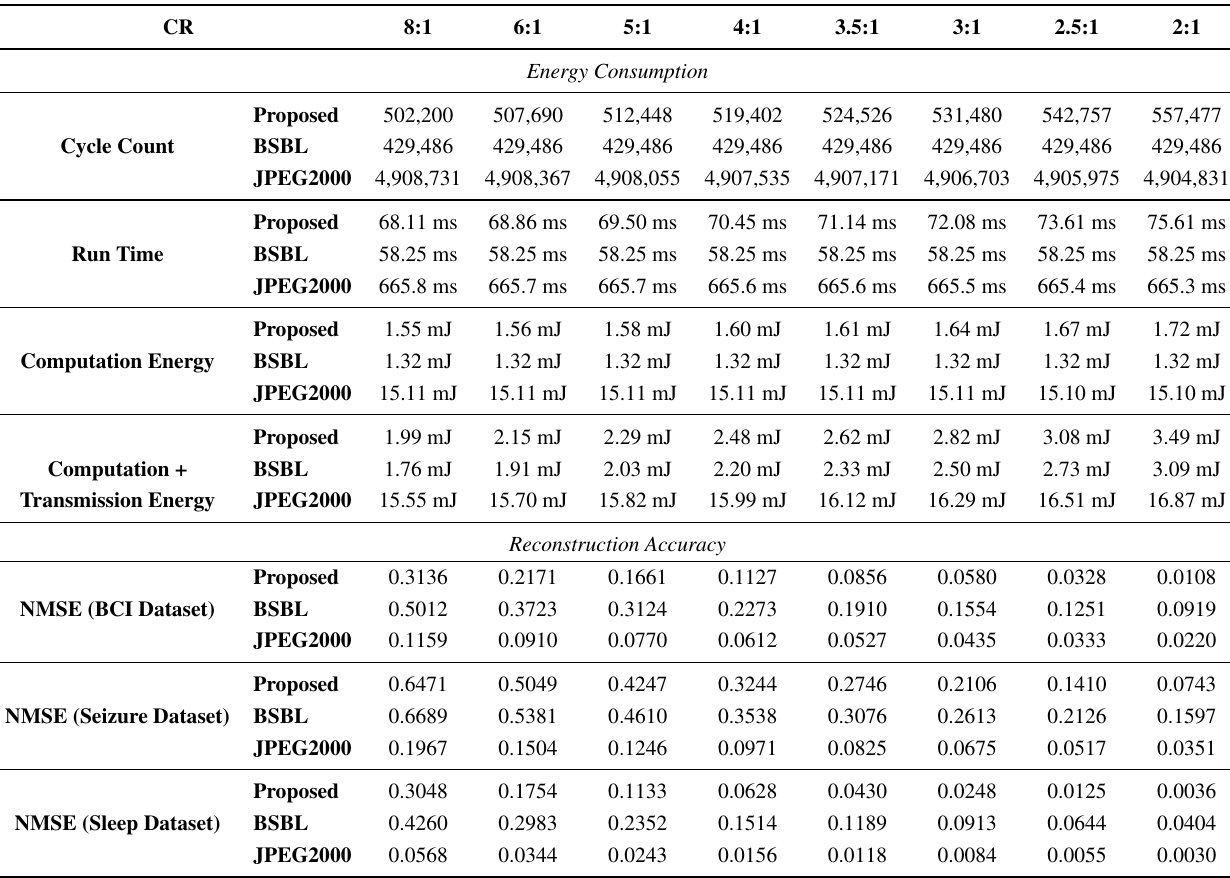
Table 1. Energy consumption and reconstruction accuracy for all frameworks. BCI, brain computer